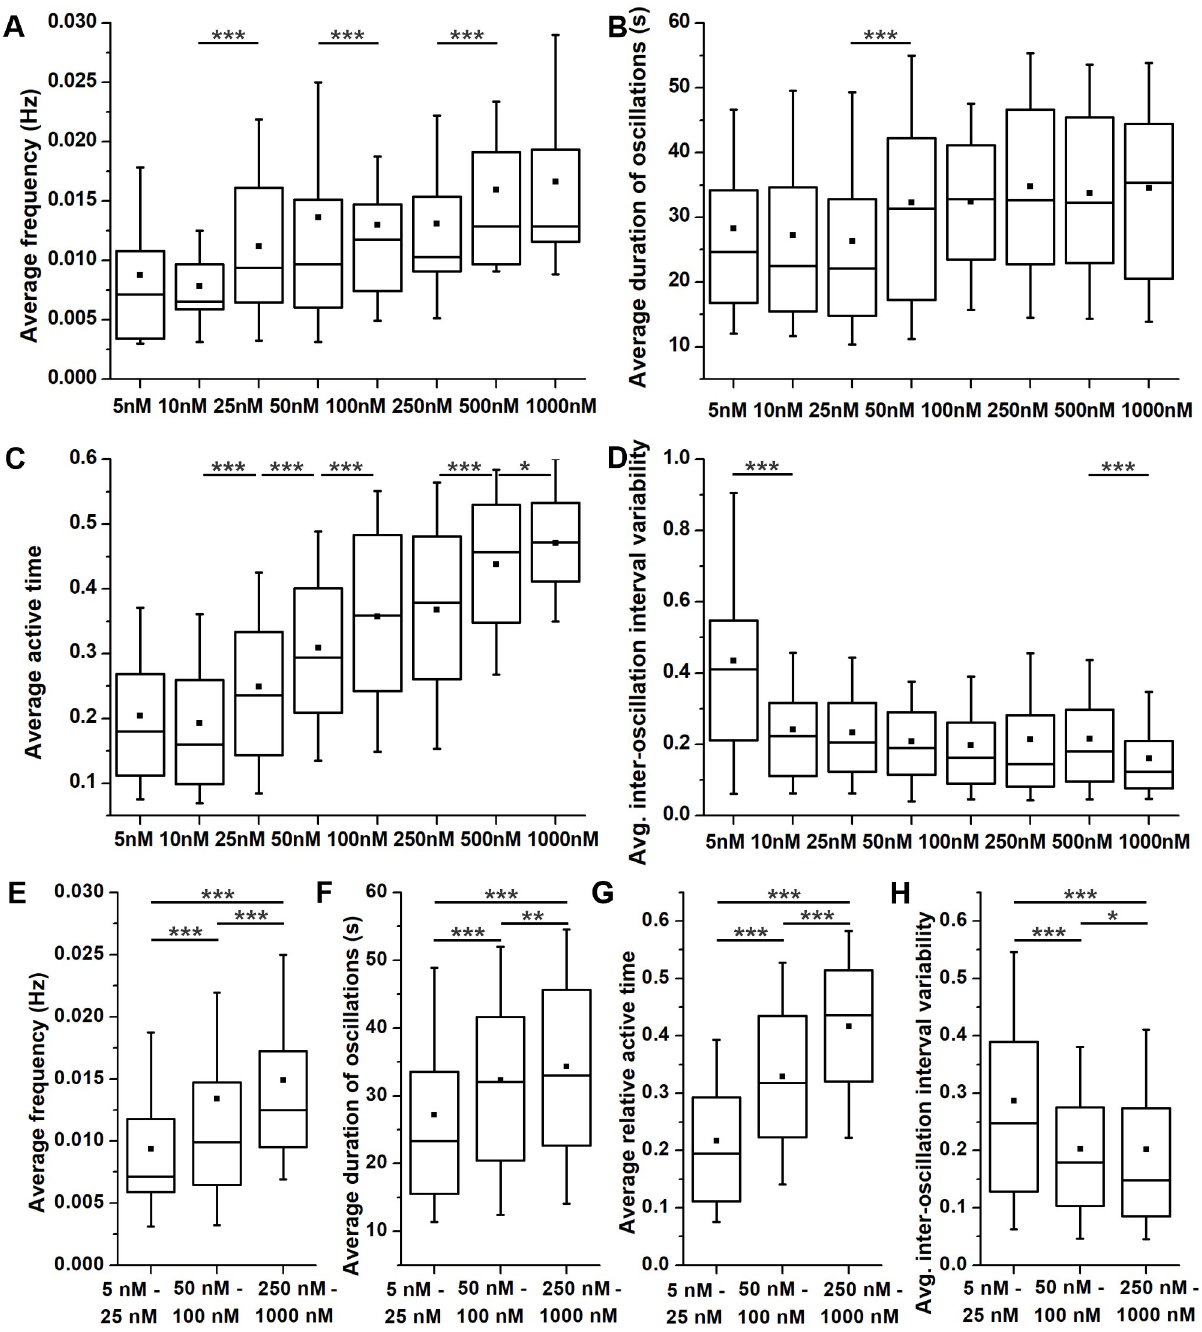
Fig 6. The dose-dependence of [Ca 2+ ] i oscillations in acinar cells upon stimulation with different concentrations of ACh. (A) and (E) Average frequency of oscillations. (B) and (F) Average duration of oscillations. (C) and (G) Average relative active time of oscillations. (D) and (H) Average inter-oscillation interval variability. Boxes determinate the interval within the 25th and the 75th percentile, whiskers denote the minimal and the maximal values, lines within the boxes indicate the median, and small squares stand for the average value. Significant differences are indicted by asterisks ( � , p < 0.05; �� , p < 0.01; ��� , p < 0.001). Panels E-H present pooled data for low (5–25 nM), medium (50–100 nM), and high (250–1000 nM) ACh concentrations. Number of analyzed slices/cells: 12/177 at 5 nM; 11/195 at 10 nM; 12/212 at 25 nM; 24/506 at 50 nM; 14/362 at 100 nM; 13/358 at 250 nM; 11/310 at 500 nM and 6/191cells at 1000